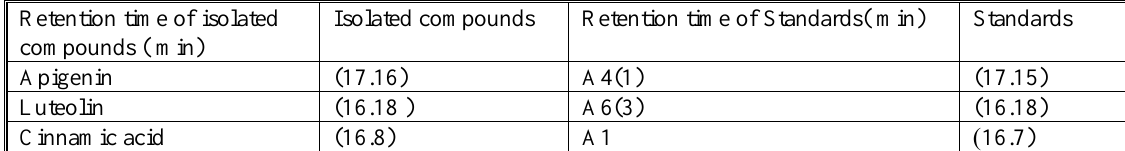
Table 6. Retention time of the standards and the isolated compounds Retention time of isolated compounds (